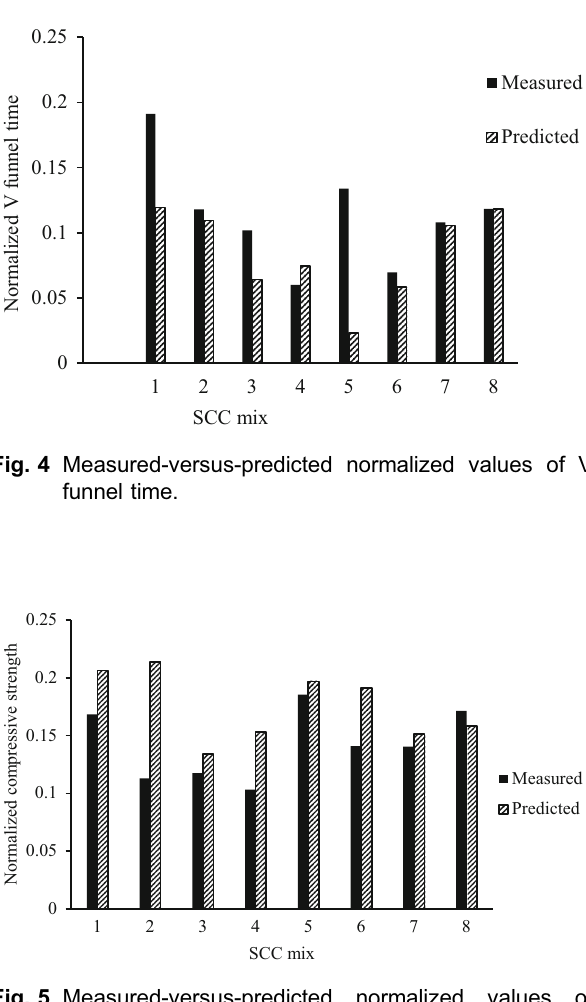
Fig. 5 Measured-versus-predicted normalized values of compressive